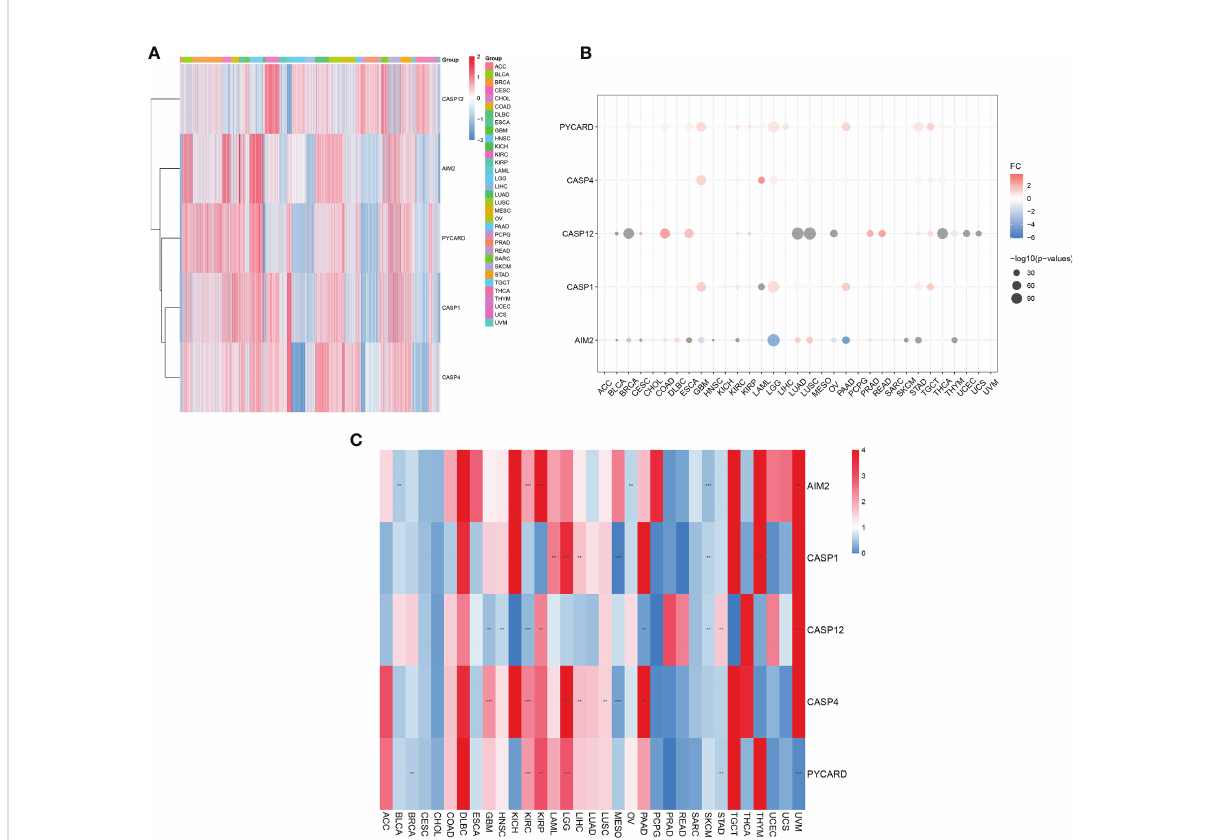
FIGURE 1 Differential expression of AIM2 in fl ammasome-related genes (AIM2i-RGs) in pan-cancer and its impact on prognosis. (A) Expression analysis of AIM2i-RGs in 33 tumors. Red represents high expression and blue represents low expression. (B) Differential expression analysis of AIM2i-RGs. Red indicates high expression in the tumor, blue indicates low expression in the tumor, and the larger the circle the smaller the P-value (Student ’ s t-test). (C) Analysis of the prognostic effect of the expression of AIM2i-RGs. Blue indicates Hazard Rate (HR) <1 and red indicates HR >1. (**p < 0.01, ***p < 0.001; COX